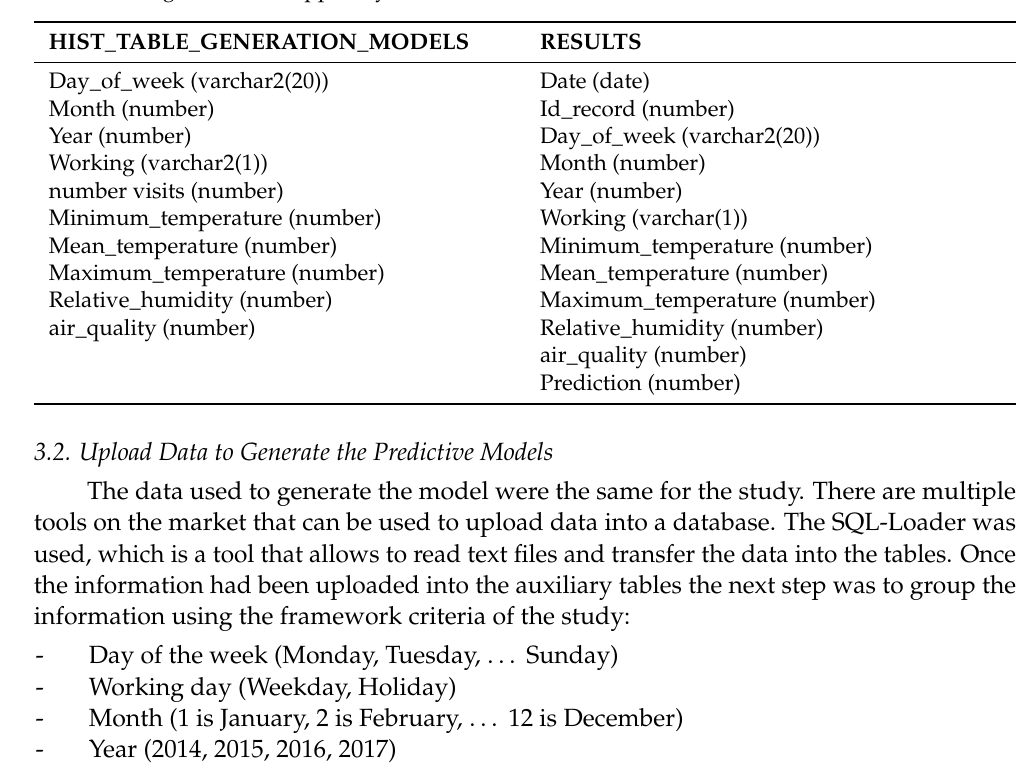
Table 2. Design decision support system